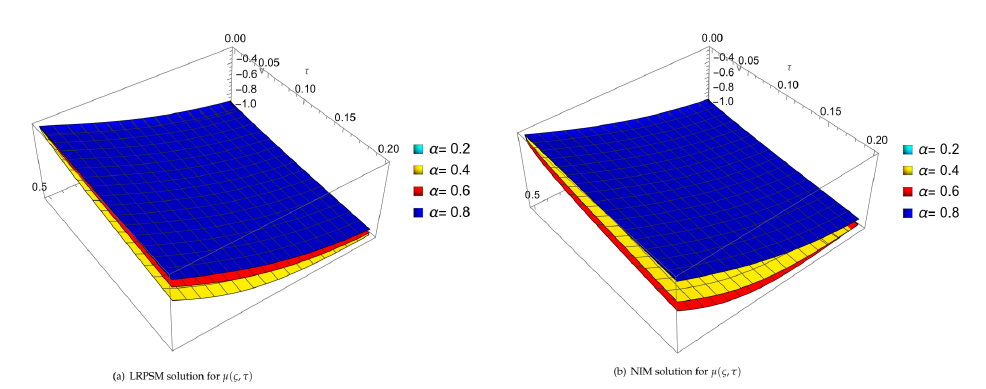
Figure 3. The 3D representations of the LRPSM and NIM solution for µ ( ς , τ ) at varying fractional orders. Table 1. The numerical results of µ ( ς , τ ) .